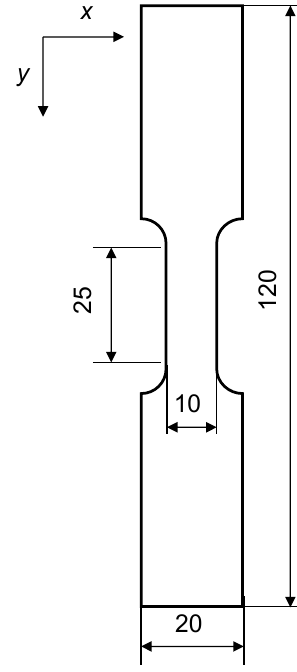
Figure 6. Shape of the Specimen.